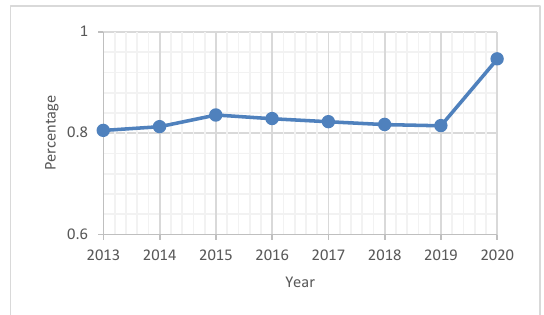
Fig. 1. Birth digital certificates evolution 2013-2020 Fig. 2. Death digital certificates evolution 2013-2020